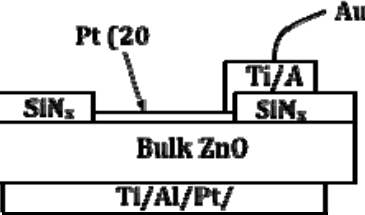
Figure 18. Schematic of AlGaN/GaN MOS diode (top) and bulk ZnO Schottky diode structure (bottom).